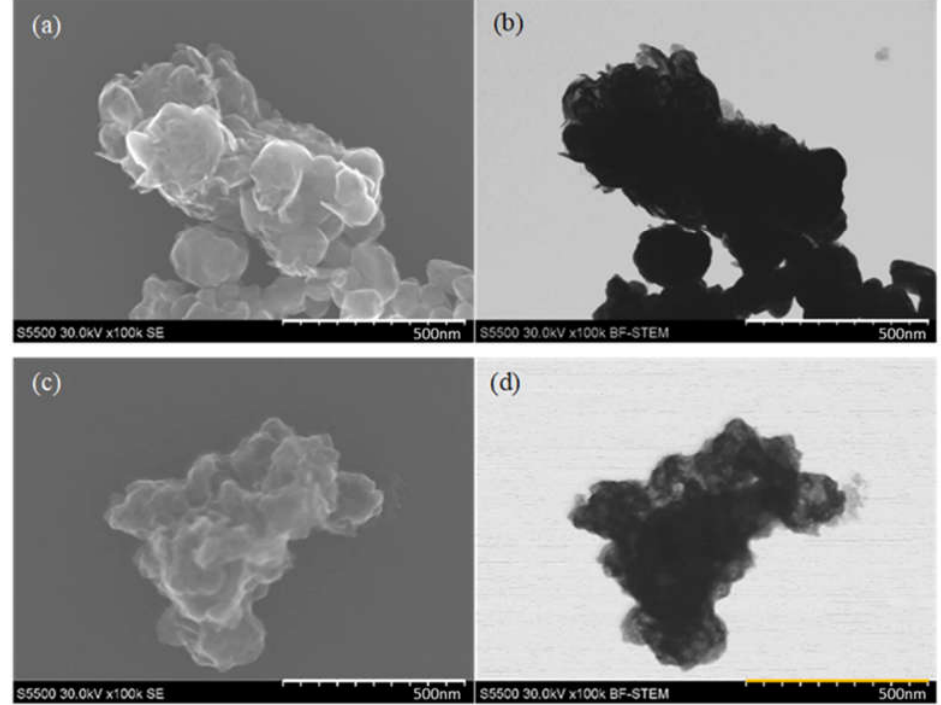
Figure 13. SEM images in ( a ) SE mode and ( b ) BF-STEM mode of MoS 2 particles obtained with the use of CA; ( c ) SE mode and ( d ) BF-STEM mode of MoS 2 particles obtained with the use of FA.